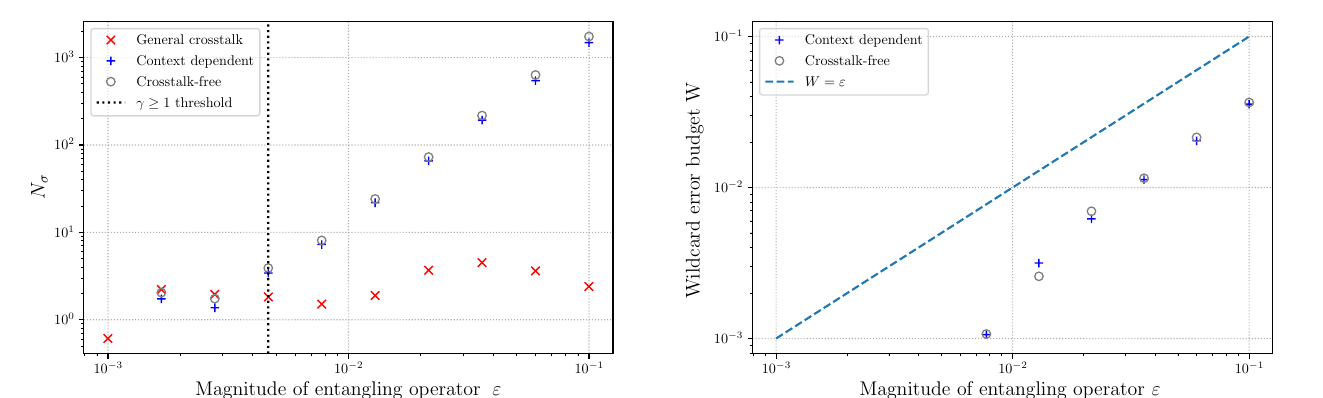
FIG. 6. Explanatory power of estimated crosstalk models ver- sus strength of entangling error (simulation). Here, N σ quantifies fit violation for each model. When ε < ε ∗ = 4.6 × 10 − 3 , the pre- dictions of all three estimated models are statistically consistent with the simulated data. As ε increases above this threshold, N σ for the context-dependent and crosstalk-free models increases rapidly, while for the general crosstalk model, it remains rel- atively constant. In this regime, the general crosstalk model is preferred by the evidence ratio test.